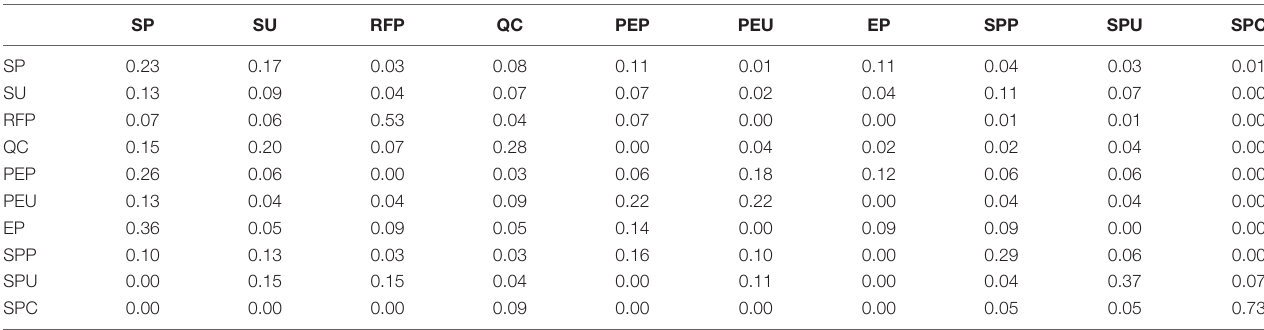
TABLE 7 | The transition matrix of the 10 most occurring states in metadiscourse